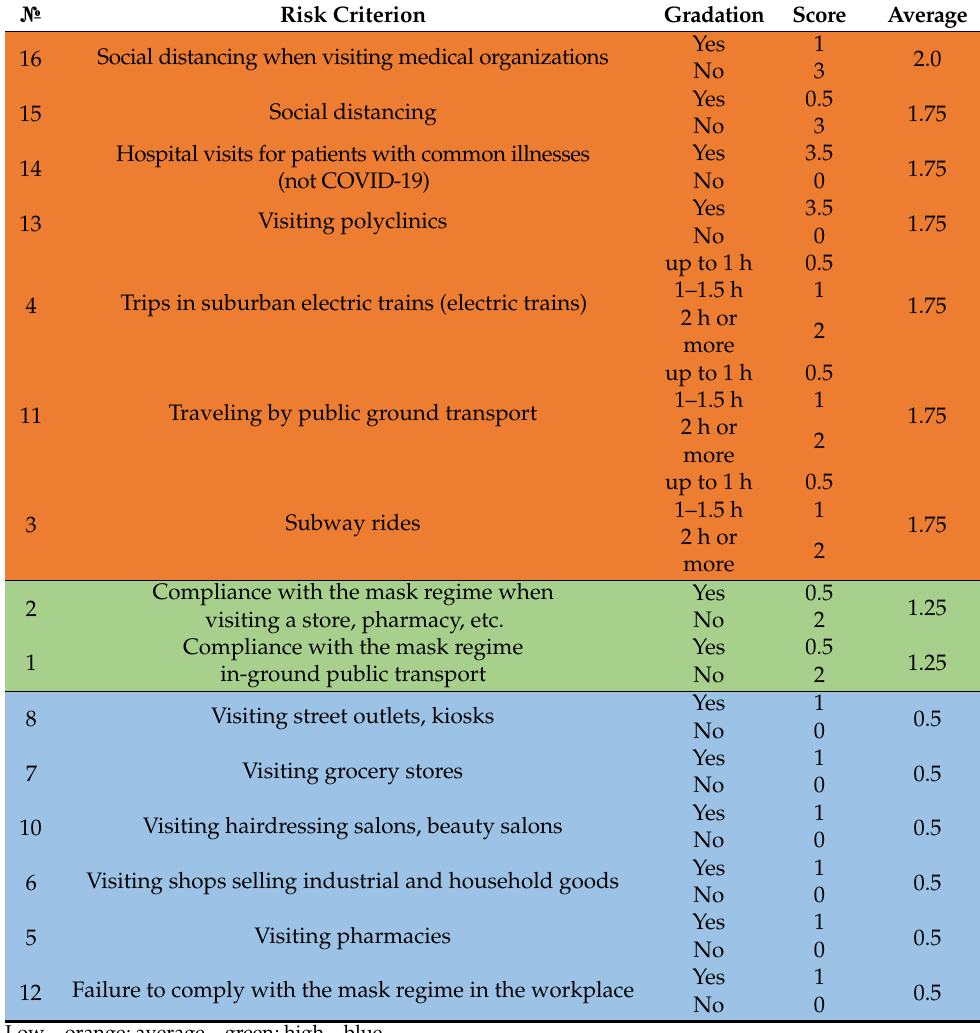
Low—orange; average—green; high—blue.